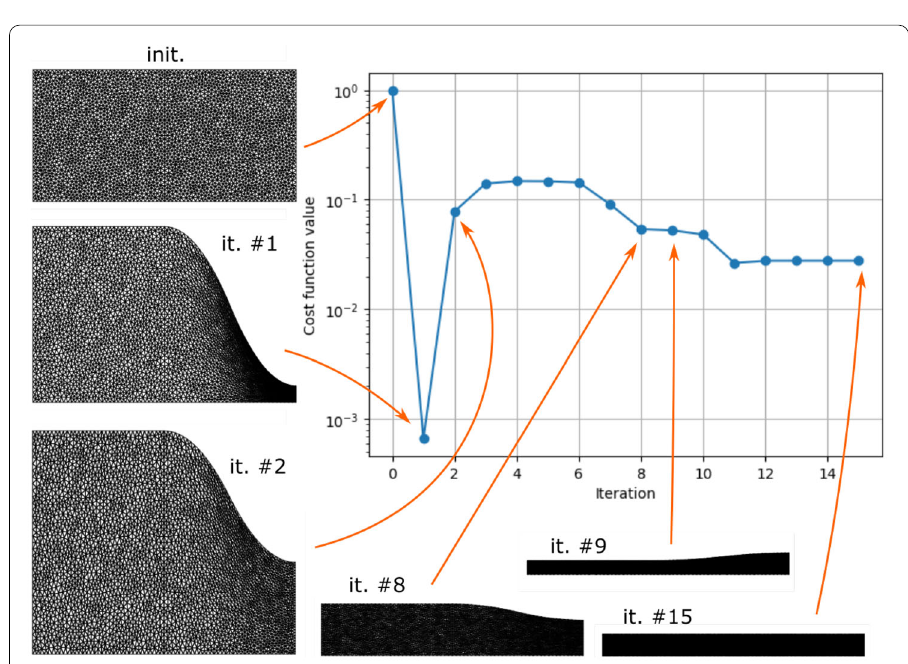
Fig. 7 Example of the isotropic plain specimen with only two spline-based design variables: evolution of the cost function value and geometry with the iteration number of the optimization